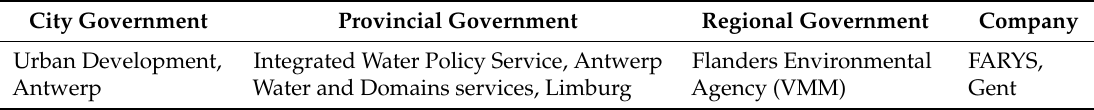
Table 3. A ffi liation of the actors